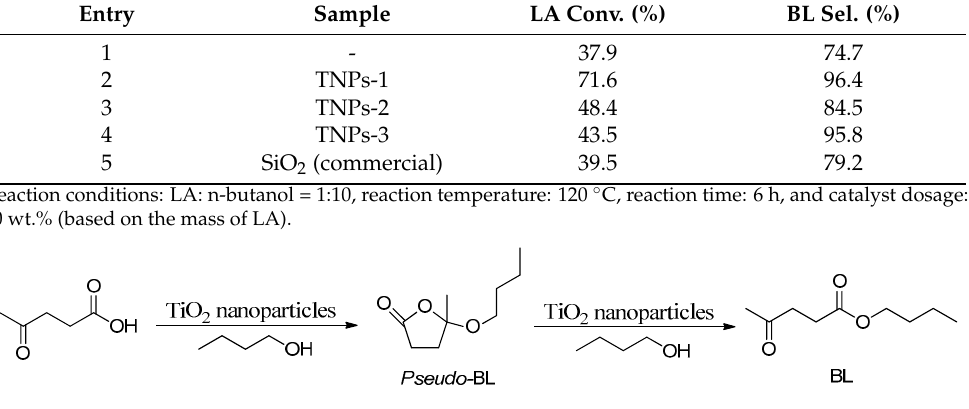
Table 1. Comparison of the various nanoparticles’ activities for LA esterification. Entry Sample